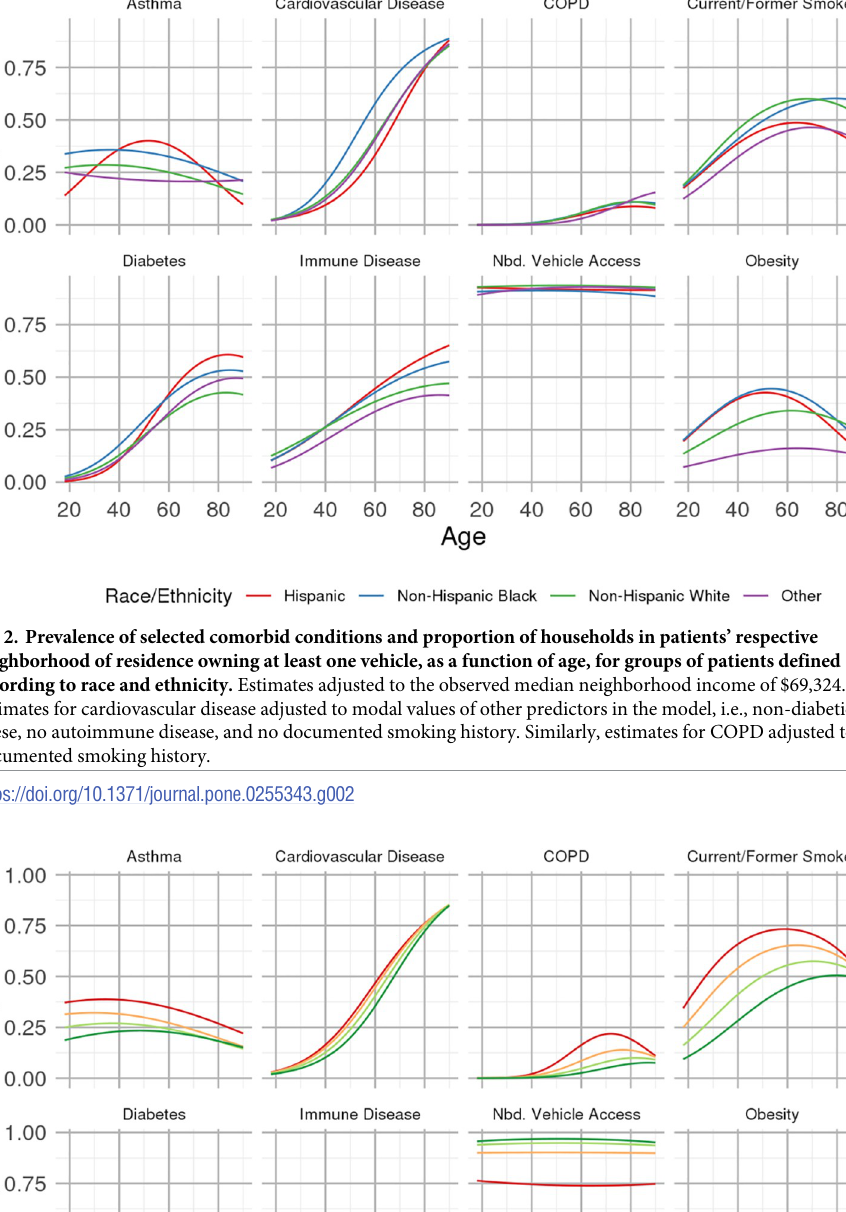
PLOS ONE | https://doi.org/10.1371/journal.pone.0255343 August 5,